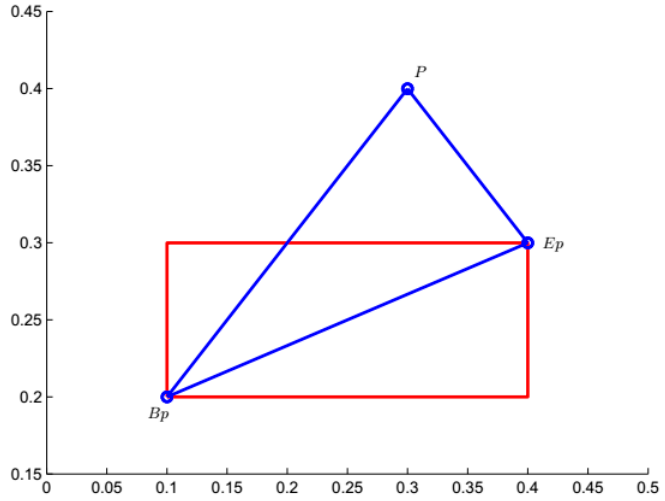
Figure 2. Distance between a point and a hyperbox granule in 2-D space.